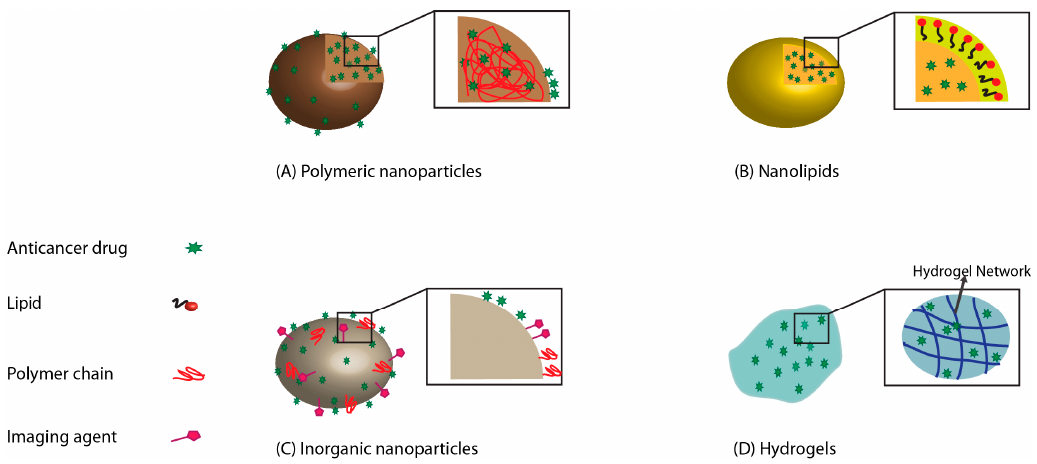
Figure 1. Different carriers used for oral cancer: ( A ) polymeric nanoparticles; ( B ) nanolipids; ( C ) inorganic nanoparticles; ( D ) hydrogels.